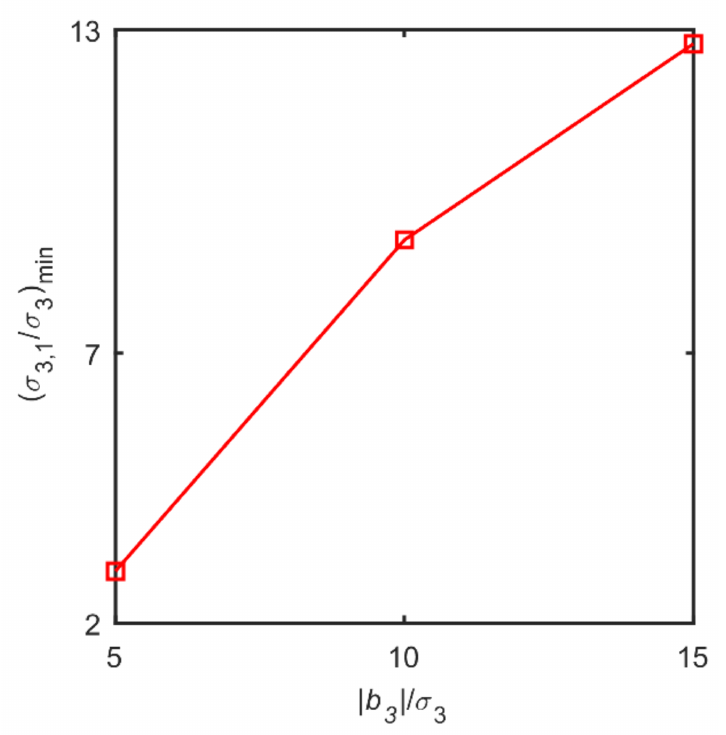
Figure 2. The influence of bias size on the estimated value of standard deviation of random error